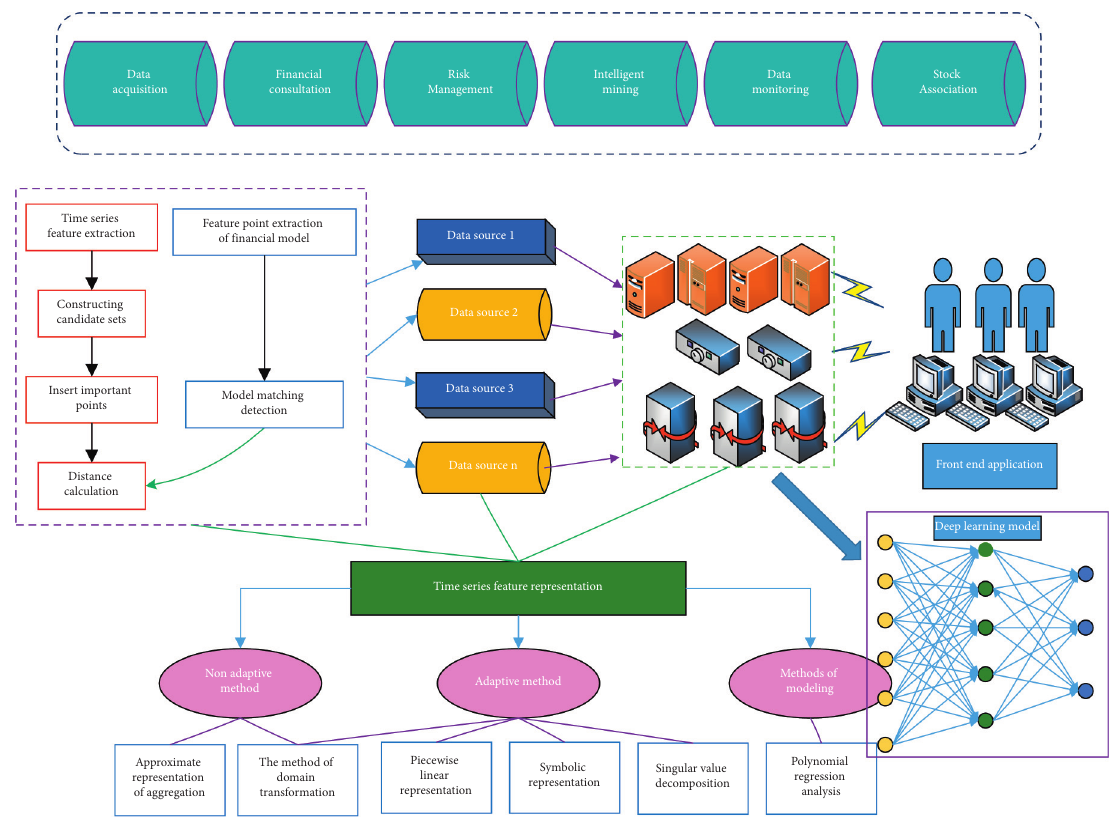
Figure 1: System architecture